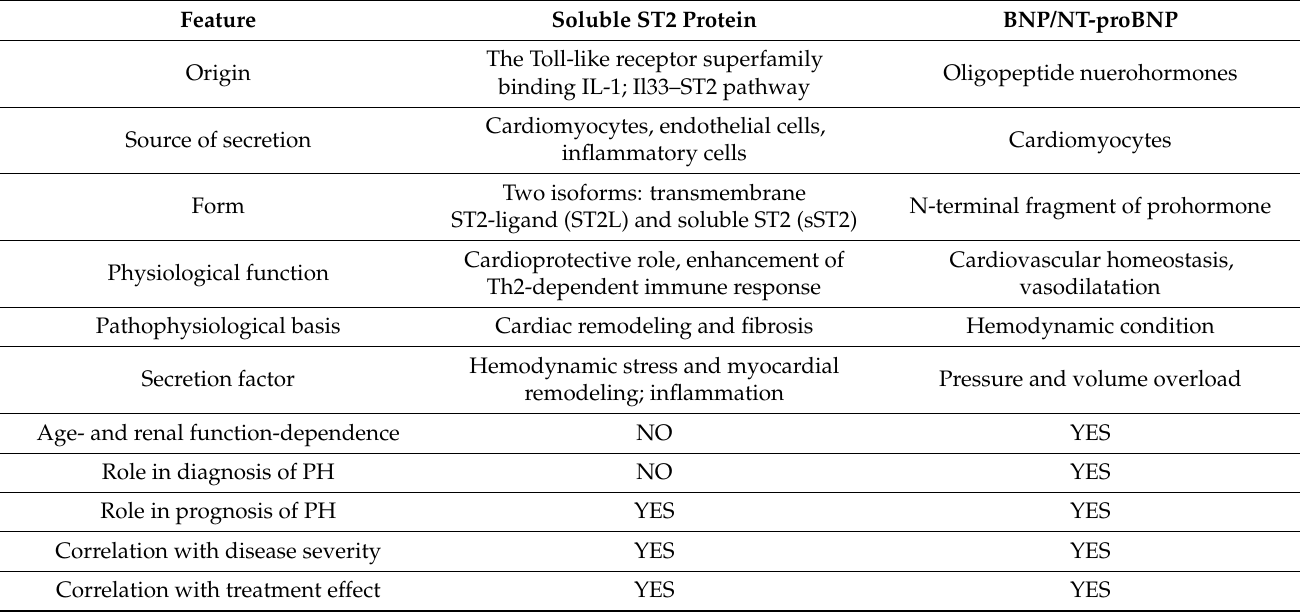
Table 3. Main differences between NT-proBNP and soluble ST2 as biomarkers in